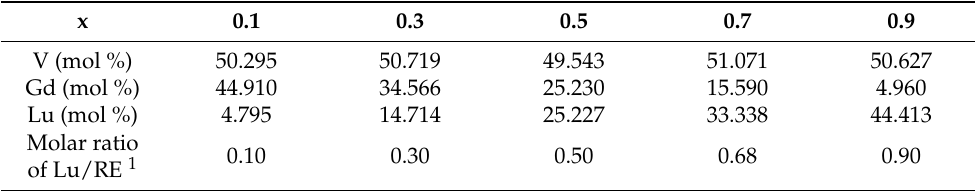
Table 1. EPMA compositions of Lu x Gd 1 − x VO 4 solid solutions.